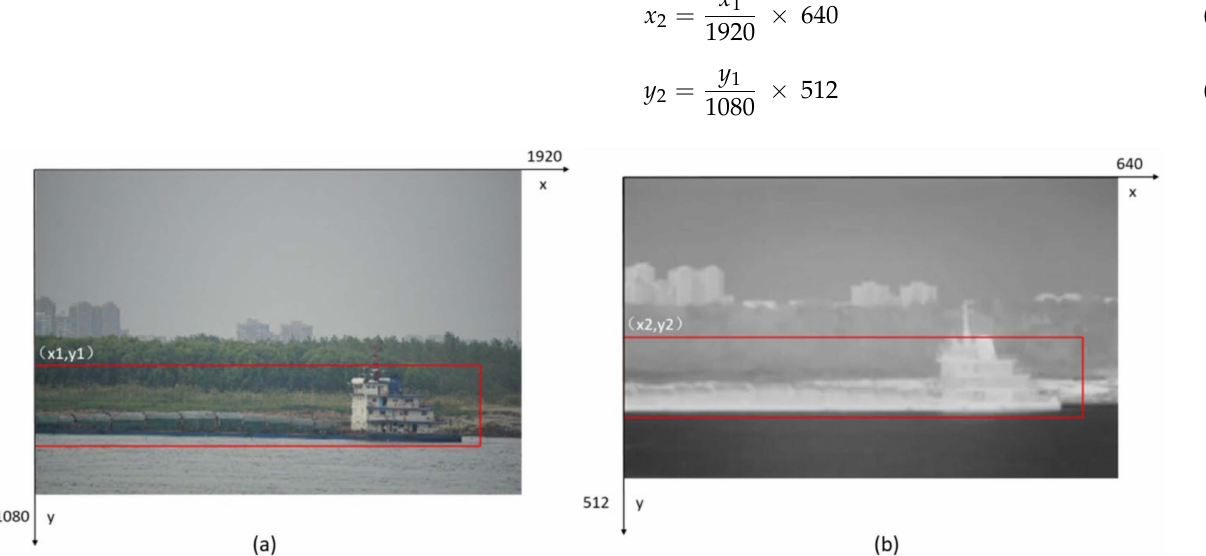
Figure 8. Schematic diagram of the same ship position in different coordinate systems. ( a ) Detec- tion results in the visible light camera coordinate system. ( b ) Detection results in infrared camera coordinate